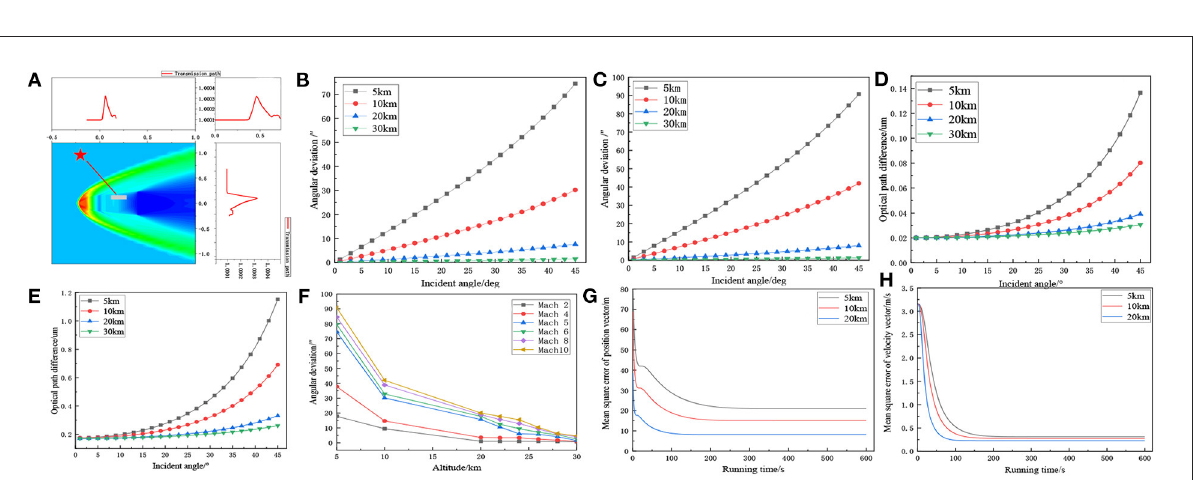
flight Mach numbers (i) density distribution and (j) temperature distribution.